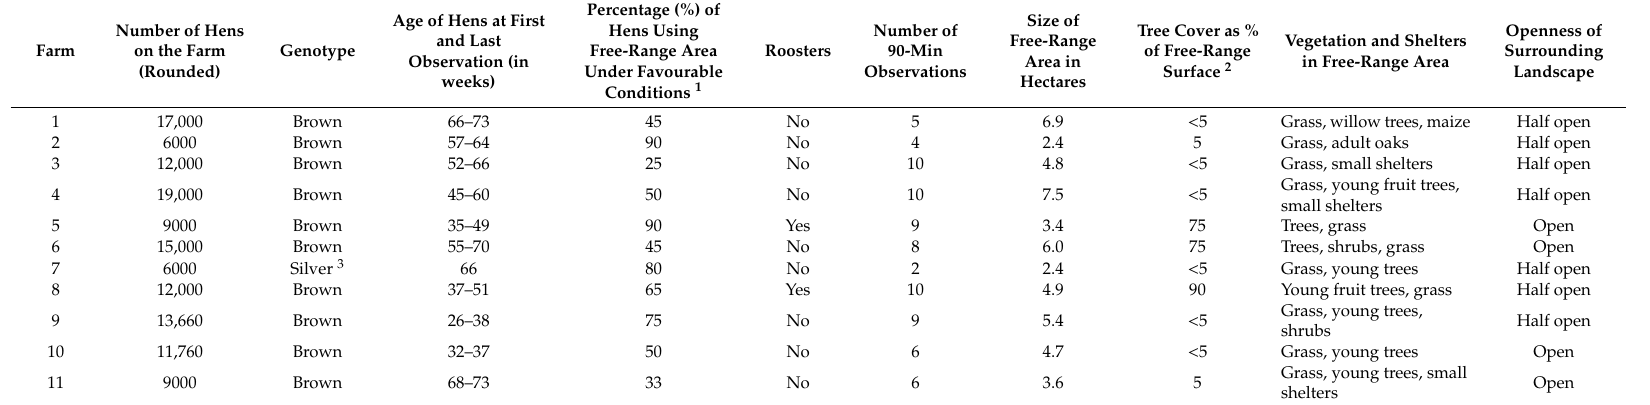
Table 1. Farms where field observations took